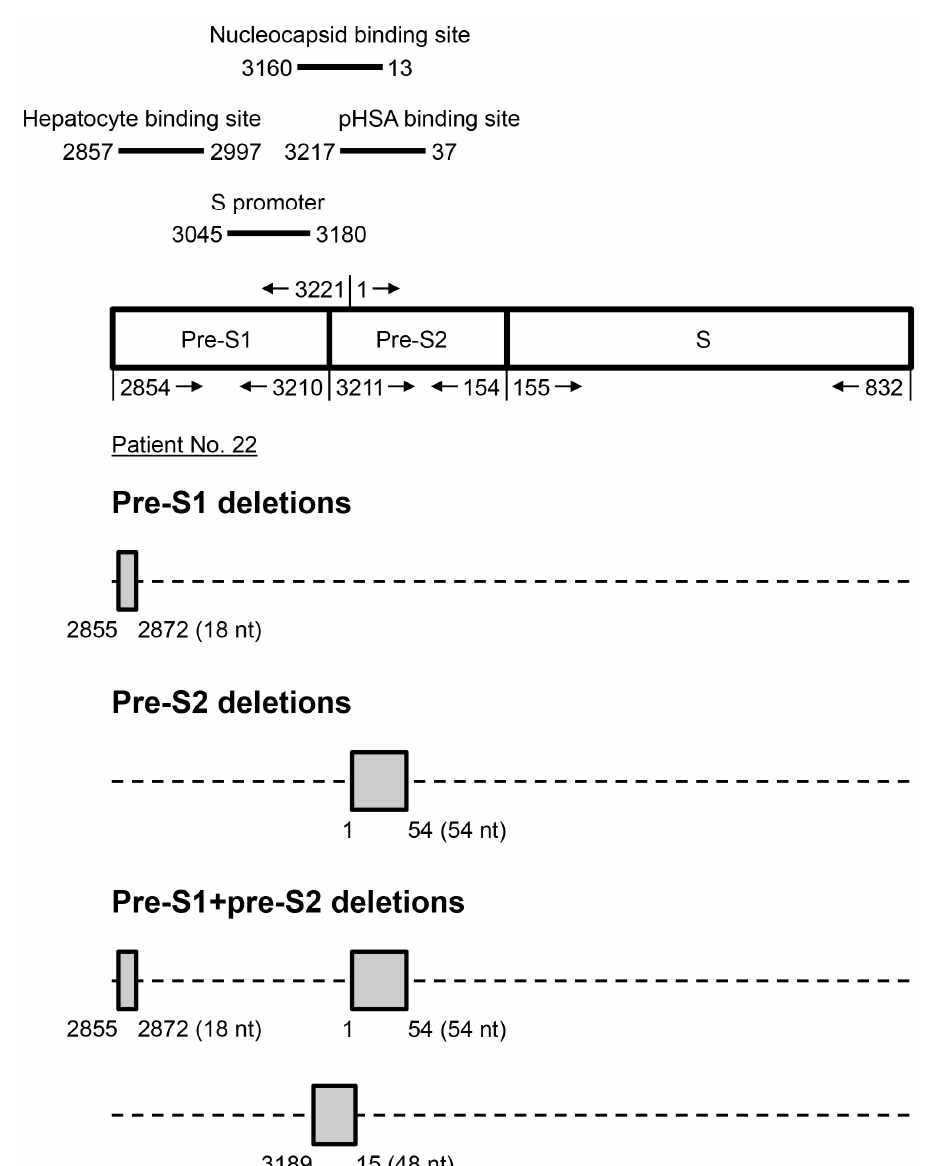
Figure 1. Schematic representation of HBV pre-S deletions. The HBV surface gene is composed of three gene segments: the pre-S1, pre-S2, and S gene segments. The numbers on the top and bottom of the diagram indicate the nucleotide (nt) positions of each gene segment in the circular HBV genome that starts at nt 1 and goes clockwise and ends at nt 3221. There are three types of pre-S deletions: the pre-S1, pre-S2, and pre-S1 + pre-S2 deletions. The pre-S1 deletions took place solely in the pre-S1 gene segment (nt 2854–3210); the pre-S2 deletions took place solely in the pre-S2 gene segment (nt 3211–3221, 1–154); the pre-S1 + pre-S2 deletions took place concurrently in both the pre-S1 and pre-S2 gene segments as two separate sites or as one site spanning those two gene segments. Shown are the representative deletion patterns from patient no. 22, who had all three types of pre-S deletions; the pre-S deletions with the highest frequency in each type were the pre-S1 deletion (nt 2855–2872), the pre-S2 deletion (nt 1–54), and the pre-S1 + pre-S2 deletion (nt 2855–2872, 1–54) (Table S1). Although the frequency was relatively lower, the pre-S1 + pre-S2 deletion (nt 3189-15) was shown to exemplify the deletions starting in the pre-S1 (nt 3189–3210) and continuously expanding to the pre-S2 (nt 3211–3221, 1–15) gene segment. The deletion size is shown in parentheses. Four representative functional sites encompassed within the pre-S gene are shown above the diagram. Abbreviations: pHSA, polymerized human serum albumin.